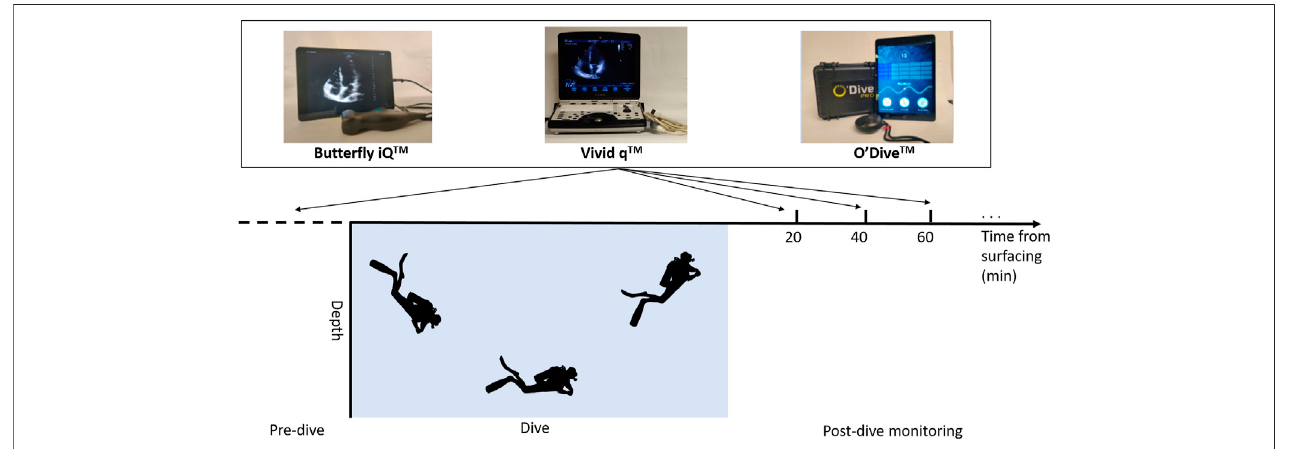
FIGURE2 | Schematic of experimental protocol depicting pre- and post-dive ultrasound recording time points. All three deviceswere used at each time point with the Vivid q ™ being the second measurement.